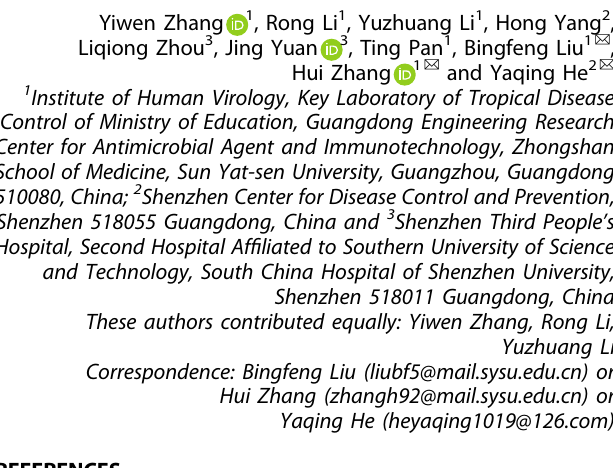
Fig. 1 Antibody response and cross-neutralization after Omicron BA.2 Infection. a , b Serum samples of BA.2-infected individuals were collected within 3 days of the fi rst positive PCR test con fi rmation. Individuals infected with BA.2 ( n = 4), individuals who received two doses of the CoronaVac vaccine prior to BA.2 infection ( n = 14), and individuals who received three doses of the CoronaVac vaccine prior to BA.2 infection ( n = 13) were included. a Speci fi city to spike variants (BA.2, D614, and Delta) and levels of antibodies in the acute phase in each of the three cohorts were measured via ELISA and are shown as the endpoint titer. b Neutralizing abilities were detected by incubating serially diluted serum samples with pseudotyped SARS-CoV-2 variants (BA.2, D614, and Delta), and the NT50 was calculated by measuring the luciferase activity of infected hACE2-293T cells. c Frequencies of BA.1, BA.2, BA.2.12.1, BA.4, and BA.5 deposited in GISAID. d Schematic of the Spike gene of SARS- CoV-2 variants, which included Delta (B.1.617.2, blue circle), BA.2 (green circle), BA.2.12.1 (yellow circle), and BA.4/5 (orange circle). Common mutations among three Omicron subvariants are marked as green triangles and indicated with black labels. Characteristic mutations in BA.2.12.1 or BA.4/5 are marked as red triangles and indicated with yellow (BA.2.12.1) or red (BA.4/5) labels. Mutations in Delta (B.1.617.2) are marked as blue triangles and labels. e Neutralizing titers against Omicron BA.2 pseudoviruses in sera from BA.2 convalescent individuals. f – h Neutralizing titers against Omicron sub-lineages and SARS-CoV-2 D614, Beta, and Delta pseudoviruses in sera from BA.2 convalescent individuals. f Individuals infected with BA.2 ( n = 6). g Individuals who received two doses of the CoronaVac vaccine prior to BA.2 infection ( n = 17). h Individuals who received three doses of the CoronaVac vaccine prior to BA.2 infection ( n = 20). i , j Neutralizing titers against Omicron sub-lineages and